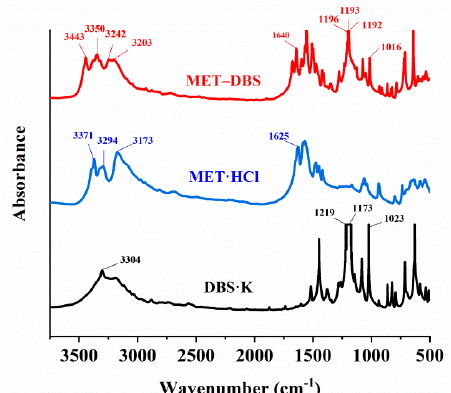
Figure 2. The FT-IR spectrum of DBS · K, MET · HCl, and MET–DBS indicated by black, blue, and red lines, respectively.